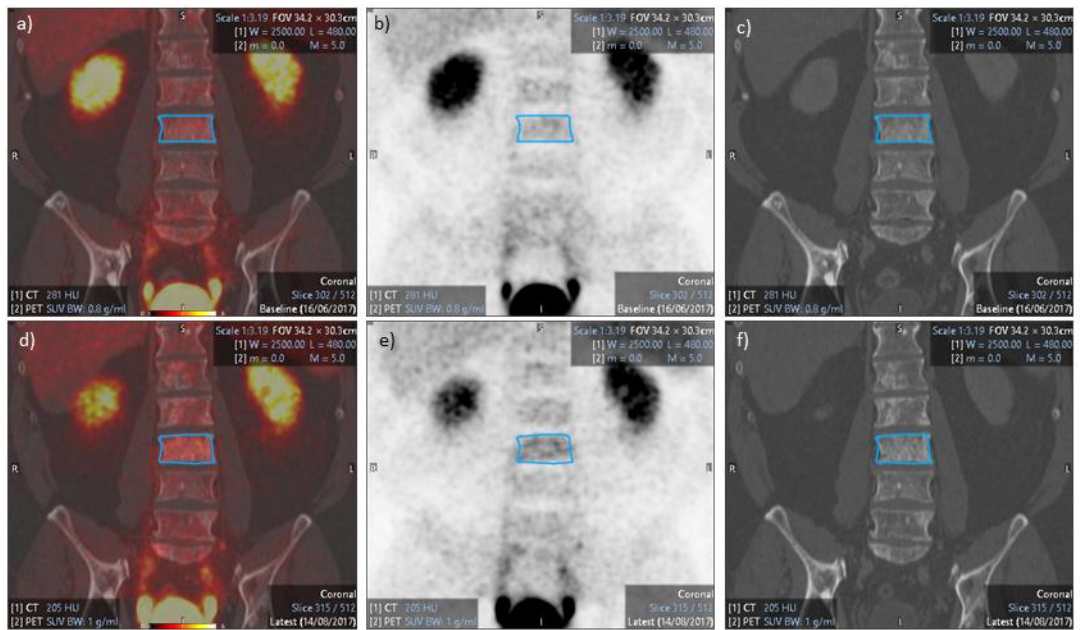
Figure 3. uPAR PET/CT (patient 10) Coronal fused images ( left ), PET images ( centre ) and CT images ( right ). Baseline images ( a – c ) and follow-up after two cycles of 223 RaCl 2 ( d – f ). Bone metastasis in lumbar spine (L3) is delineated, baseline SUVmax was 2.4 and after two cycles of 223 RaCl 2 increased to 3.9. After end of therapy the patient was diagnosed with epidural involvement at L3 and received EBRT to relieve symptoms.